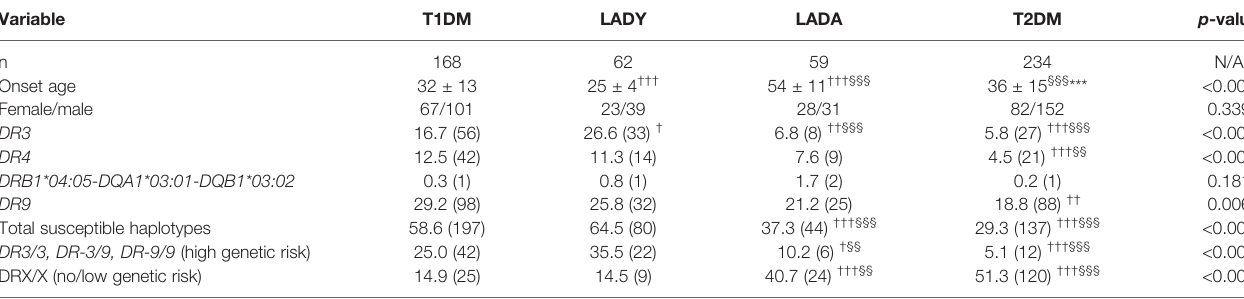
LADA patients (T1D vs. LADA: 58.6% vs. 37.3%, p < 0.001; LADY vs. LADA: 64.5% vs. 37.3%, p < 0.001). Moreover, the frequencies of high-risk genotypes were higher in T1D and LADY patients than that in LADA patients (T1D vs. LADA: 25.0% vs. 10.2%, p < 0.05; LADY vs. LADA: 35.5% vs. 10.2%, p < 0.01). In contrast, T1D and LADY patients had lower frequencies of low/no genetic risk genotypes ( DRX/X ) than the frequencies of LADA patients (T1D vs. LADA: 14.9% vs. 40.7%, p < 0.001; LADY vs. LADA: 14.5% vs. 40.7%, p < 0.01). Unexpectedly, LADY patients had a higher frequency of the susceptible haplotype DR3 than that of T1D patients (26.6% vs. 16.7%, p < 0.05). There were no signi fi cant differences between LADY and T1D patients in the frequencies of total susceptible HLA haplotypes, high-risk genotypes, and low/no genetic risk TABLE 3 | The frequency of susceptible HLA haplotypes and genotypes among T1DM, LADY, LADA, and T2DM subjects. Variable T1DM